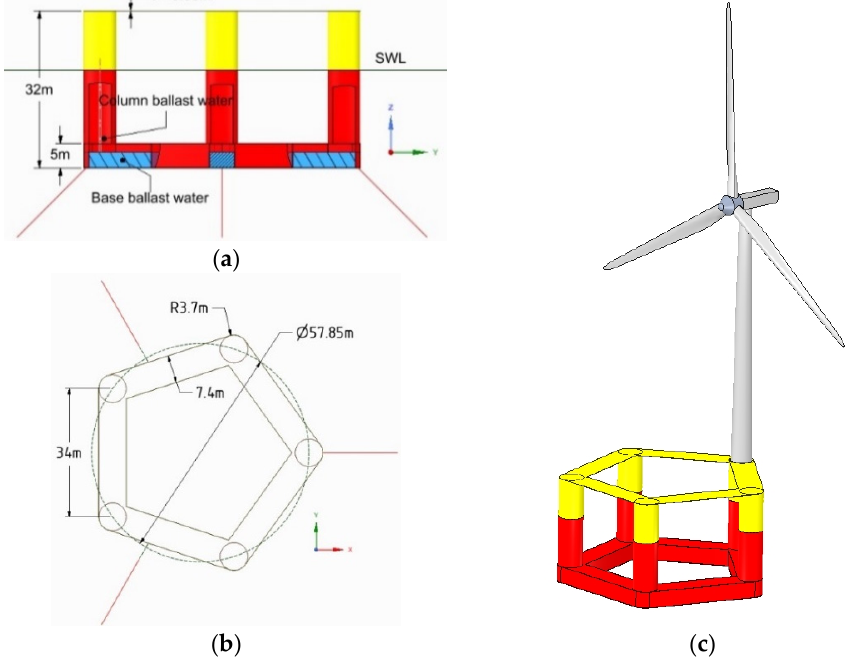
Figure 12. Sketch of five-column platform floating wind turbine system: ( a ) front view of five-column platform; ( b ) top view of five-column platform; ( c ) isometric view of five-column floating wind turbine system.